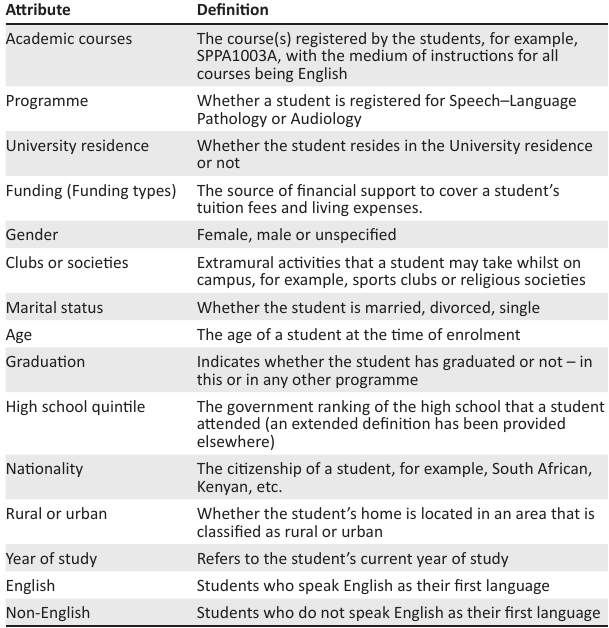
TABLE 1: Attributes extracted from students’ records.